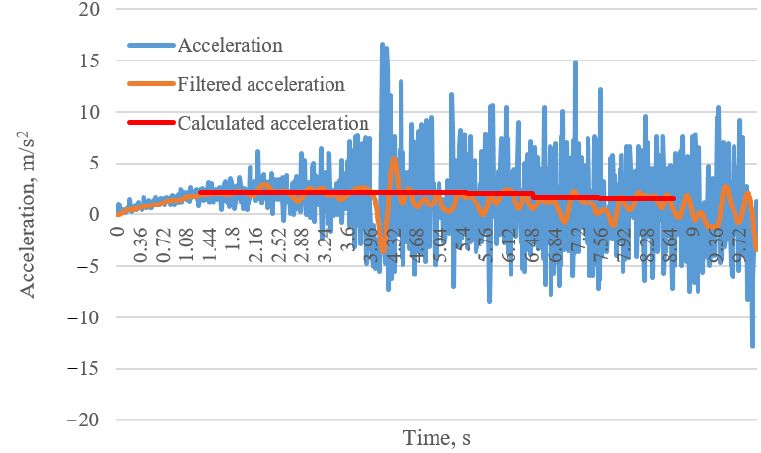
Figure 8. Second test ’s acceleration results compared with calculated results.